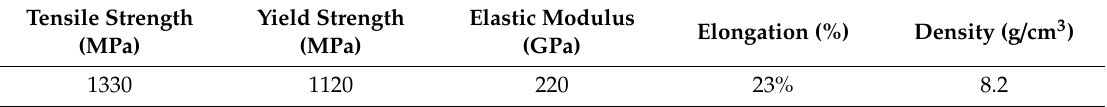
Table 2. Main mechanical and physical properties of Inconel 718 nickel alloy.